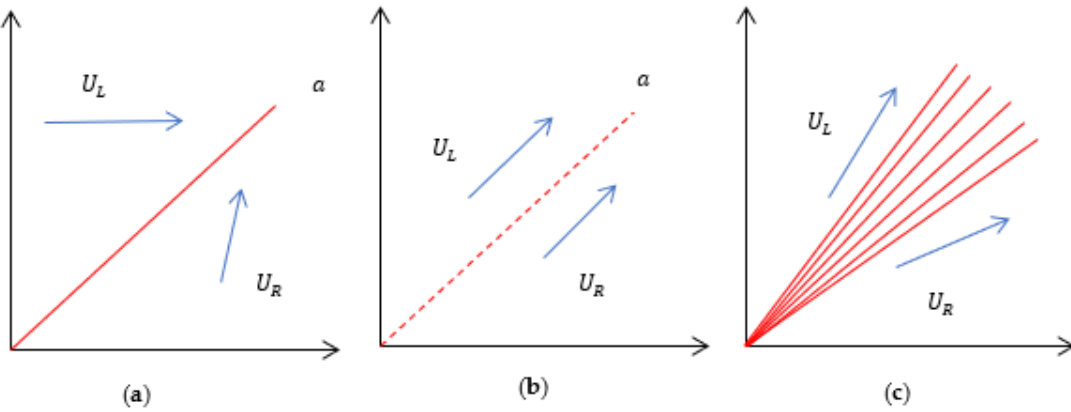
Figure 7. Elementary wave solutions to the Riemann problem: ( a ) shock wave— U L and U R connected through single jump discontinuity; ( b ) contact discontinuity— U L and U R connected through single jump discontinuity of speed a in a linearly degenerated field; and ( c ) rarefaction wave— U L and U R connected through a smooth transition in a nonlinear